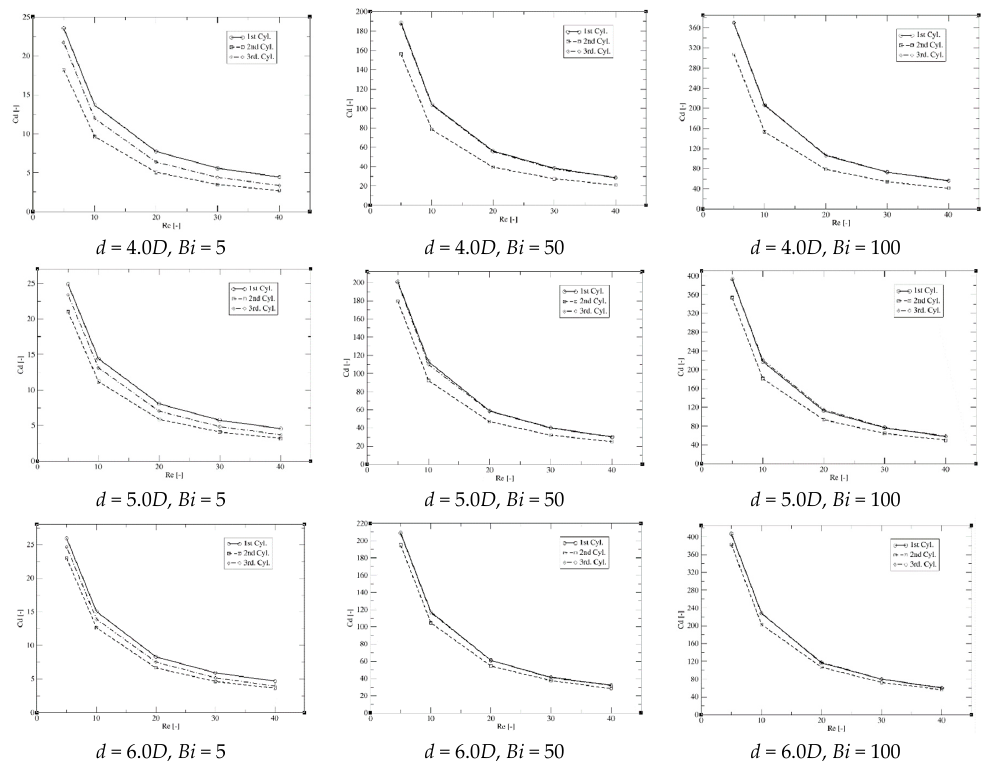
Figure 6. Drag variation over three cylinders for various separation distances and Bingham numbers.